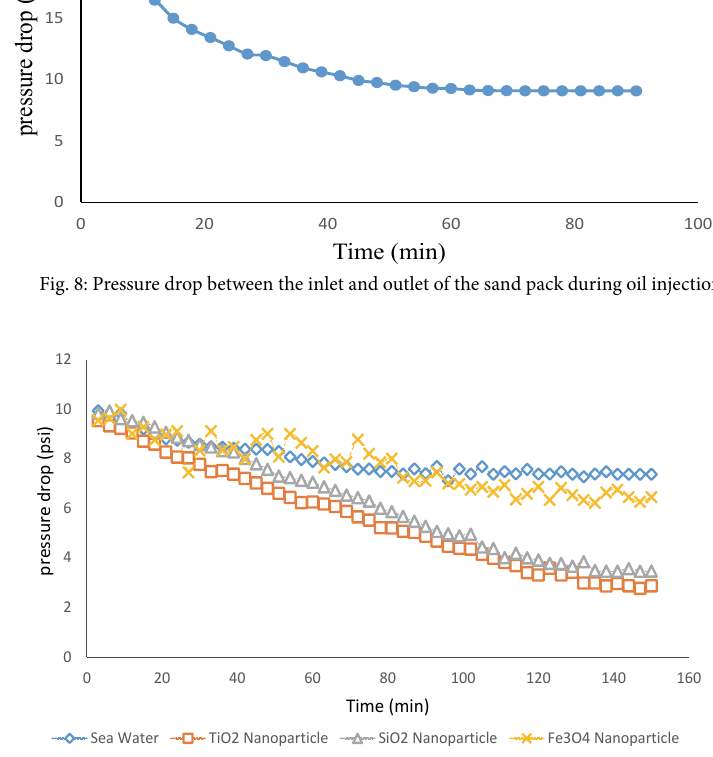
Fig. 9: Pressure variations in the system versus time during nanofluid and seawater injection